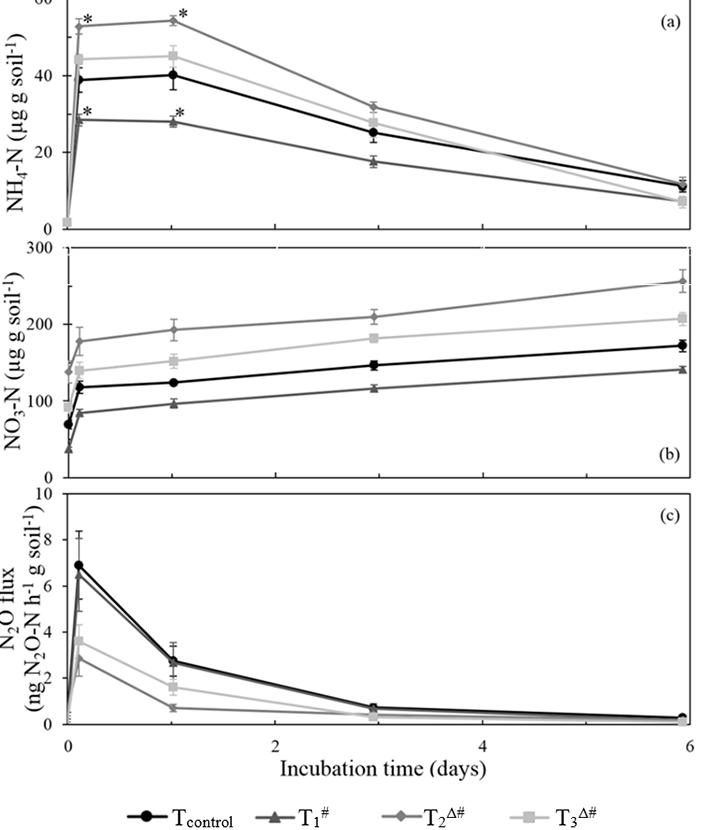
Figure 3. NH 4 -N content (a) , NO 3 -N content (b) and N 2 O emissions (c) at the extraction times. Time point 0 is the time of label addition ( 15 NH 4 NO 3 Gly, NH 15 NO 3 Gly or NH 4 NO 15 N Gly). The ammonium and nitrate content at time point 0 is based on unlabelled soil. 4 3